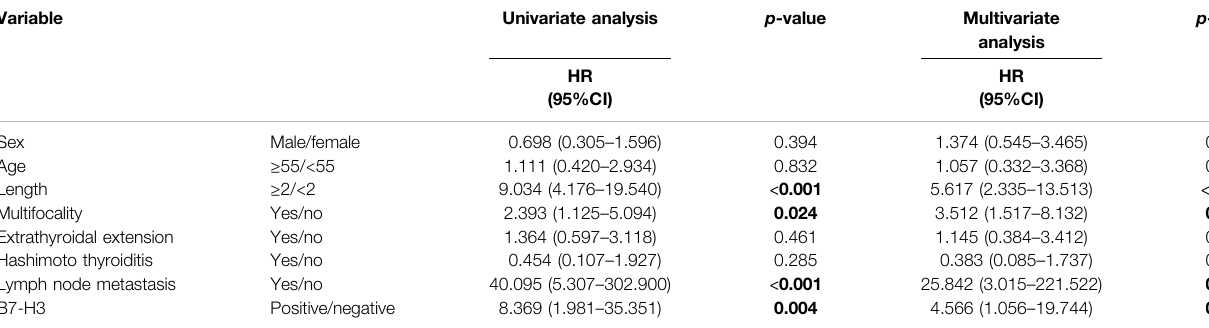
TABLE 2 | Univariable and multivariable Cox regression analyses for RFS in PTC patients.